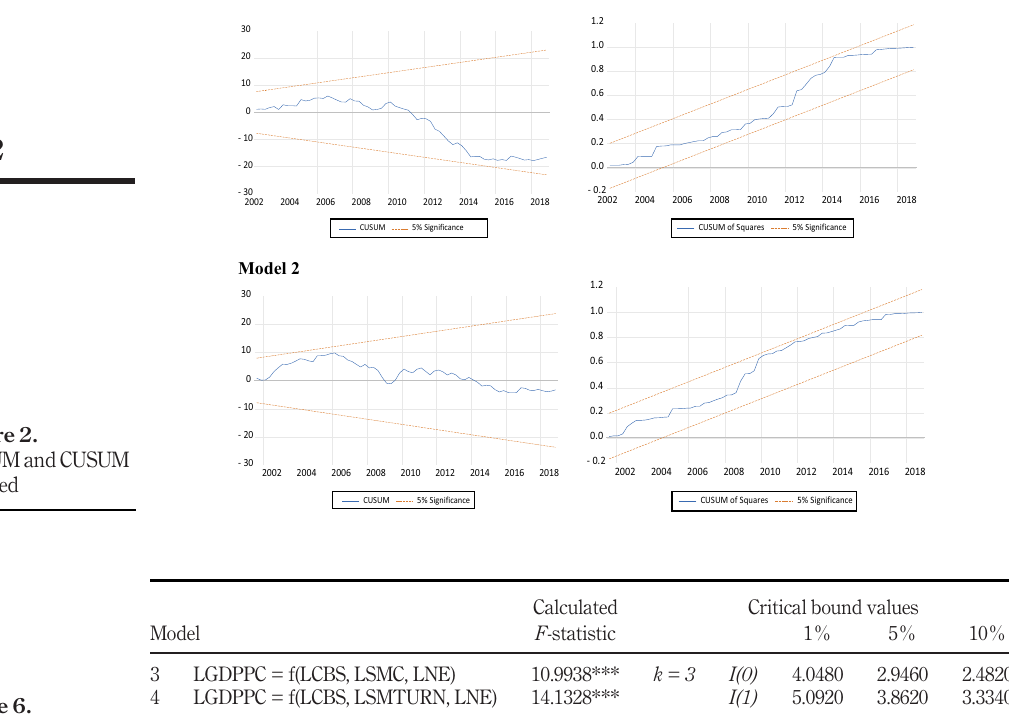
Table 6. The bounds test for cointegration: an alternative measure